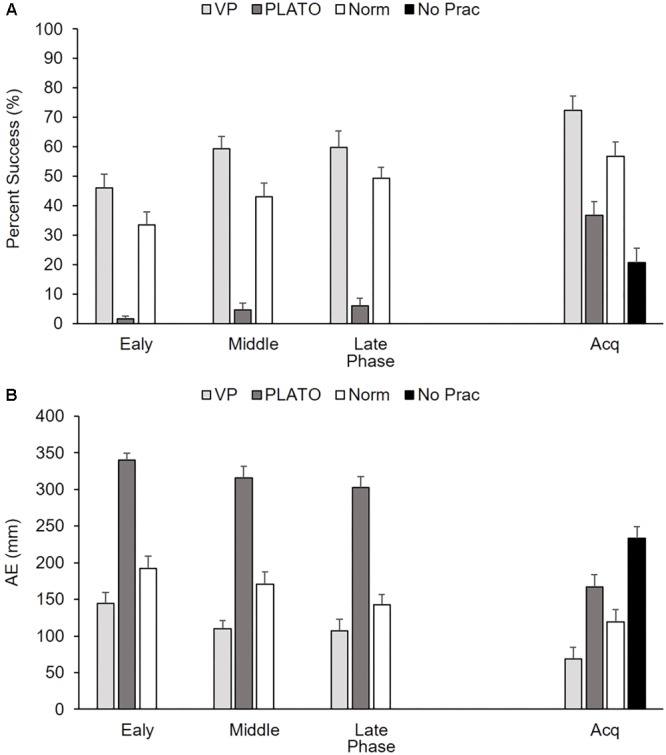
Group mean (+SEM) percent successful responses (A) and AE (B) as a function of group (VP-Nike Vapor Strobe®; PL - PLATO Visual Occlusion; Norm - Normal Vision; No Prac - Control) across practice phase (early, middle, and late) and acquisition (Acq). There is no practice data for the control group as they did not complete any perceptual-motor training. NB. Means for acquisition reflect post-test means adjusted based on the pre-test scores (Success = 20%; AE = 257 mm).